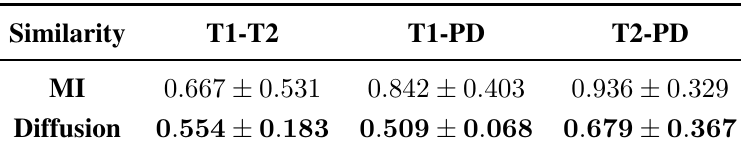
Table 3. Mean (non-rigid) registration error for BrainWeb data sets. Errors (mean ± standard deviation) are in mm.